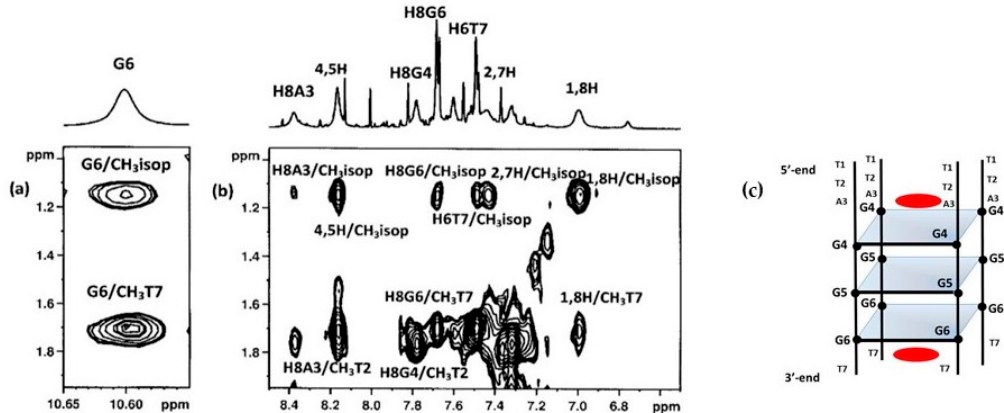
Figure 3. Selected region of the 2D NOESY spectrum of d(TTAGGGT) 4 /curaxin complex. ( a ) G6 imino proton displays intermolecular NOEs between CH 3 T7 and CH 3 (isopropyl) of curaxin; ( b ) A3, G6 and T7 aromatic protons and methyl groups of T2 and T7 of T2AG3T display intermolecular NOEs with CH 3 (isopropyl) and aromatic protons of curaxin; ( c ) schematic representation of d(TTAGGGT) 4 /curaxin (in red) complex.